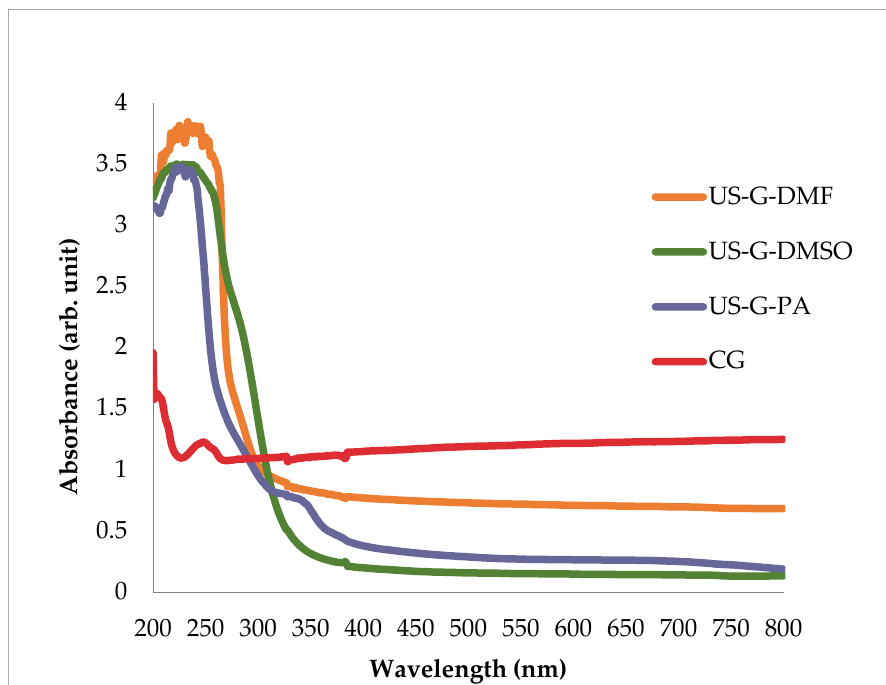
Figure 6 . UV-vis spectra of CG, G-DMSO, G-DMF, and G-PA products. Figure 6. UV-vis spectra of CG, G-DMSO, G-DMF, and G-PA products.